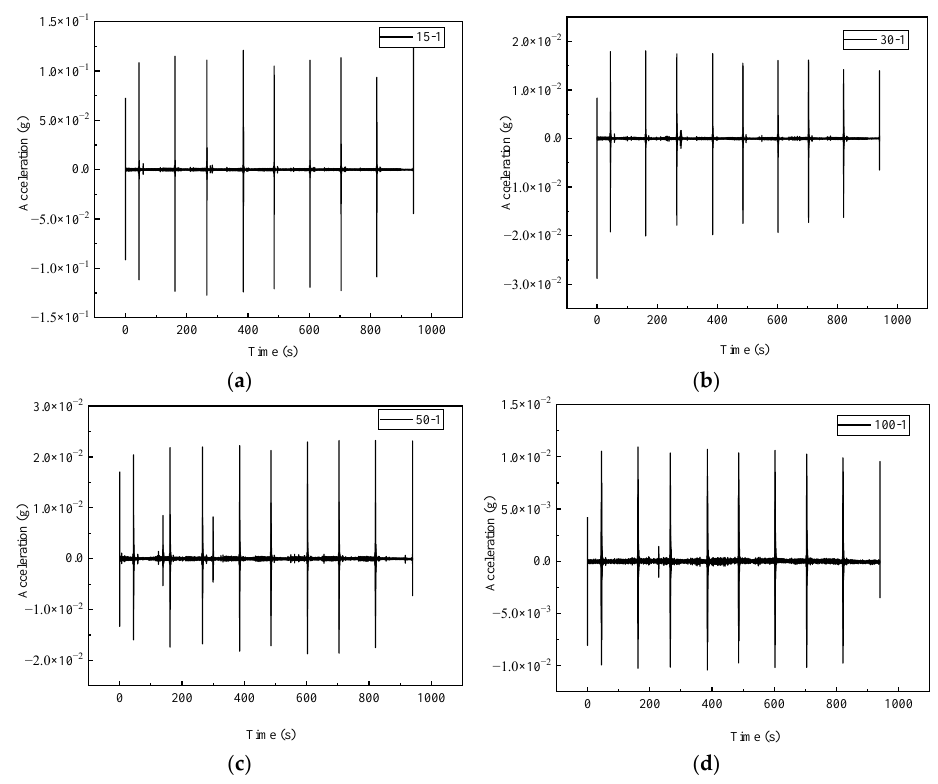
Figure 4. Acceleration time history curves in the vertical direction: ( a ) 15-1; ( b ) 30-1; ( c ) 50-1; ( d ) 100-1.